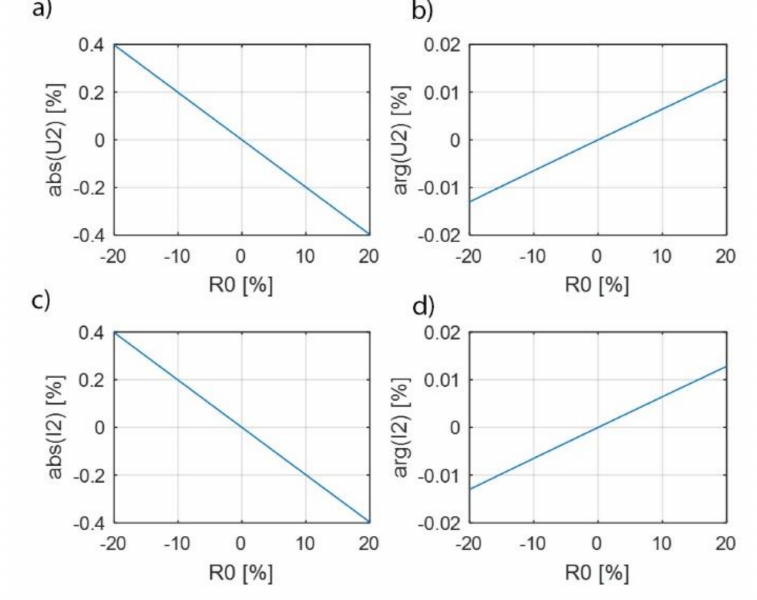
Figure 14. Changes of wave parameters depending on R 0 at f = 100 kHz; ( a ) U 2 voltage modulus, ( b ) U 2 argument, ( c ) I 2 modulus, ( d ) I 2